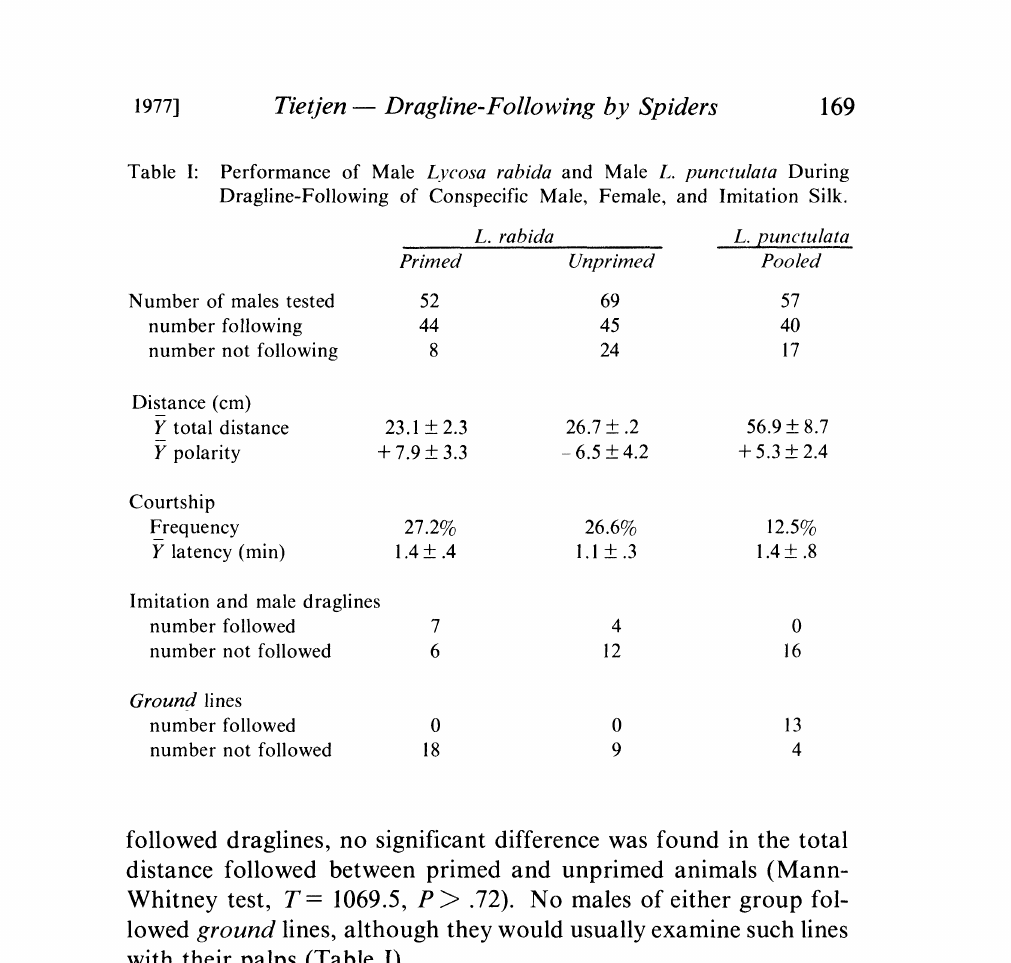
Table I: Performance of Male Lycosa rabida and Male L. punctulata During Dragline-Following of Conspecific Male, Female, and Imitation Silk. L. rabida L.unctulata